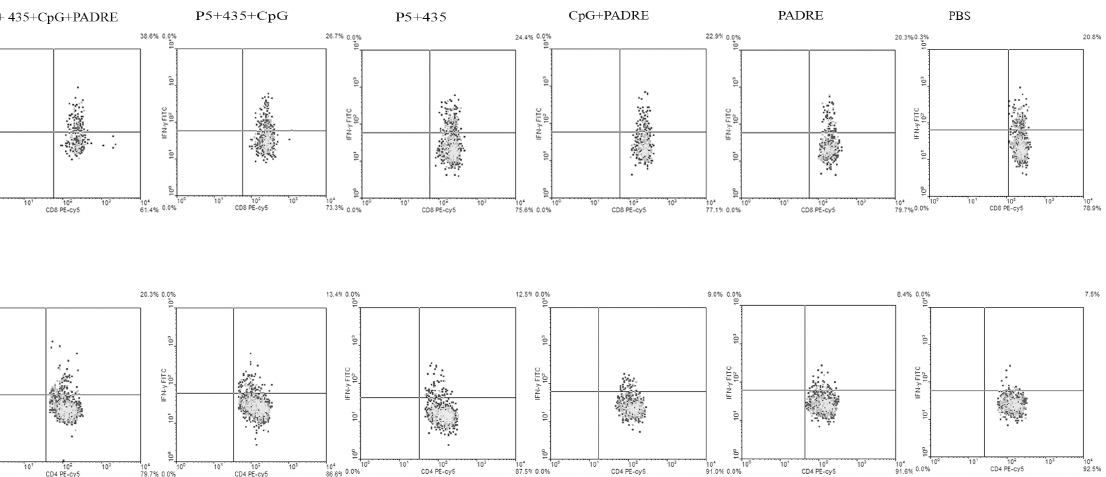
Fig 2. The percentages of IFN- γ producing CD4+ and CD8+ T cells. Flow cytometry data were also analyzed according to the percentage of cytokine- producing cells and dot plots were drawn for each vaccinated group. Quadrants showing dot plot of CD8 and CD4 cells producing IFN- γ percentage. Spleen cells were analyzed using a gating strategy to exclude debris and identify CD4+ and CD8+ T cells. The subsequent analysis was on CD8+ or CD4+ gates to describe IFN- γ -producing T cells.